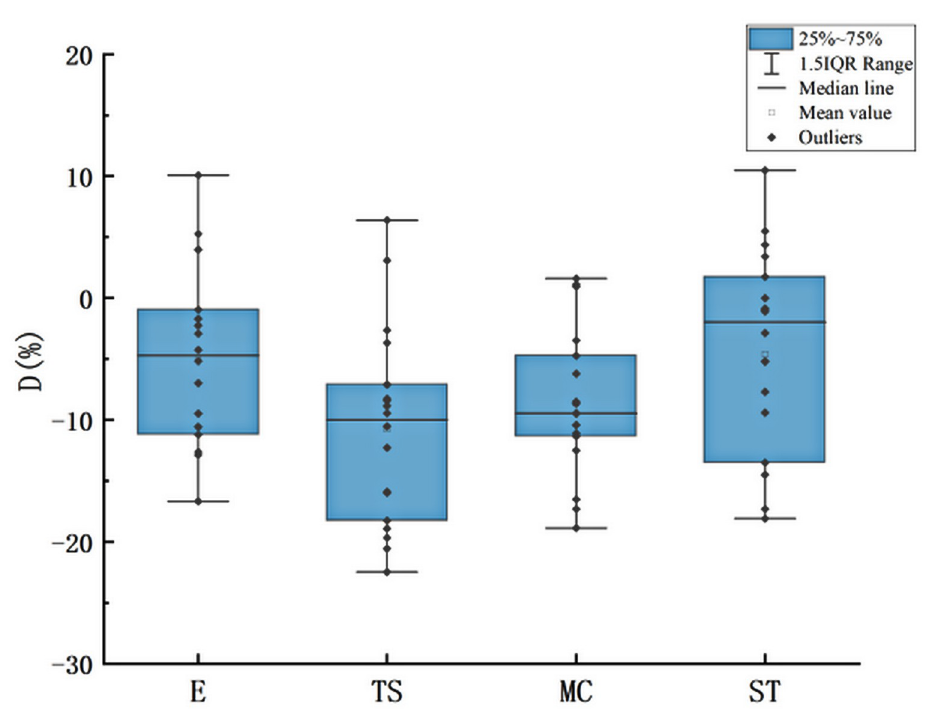
Fig 14. D-value distribution of 18 subjects (R = 800m).